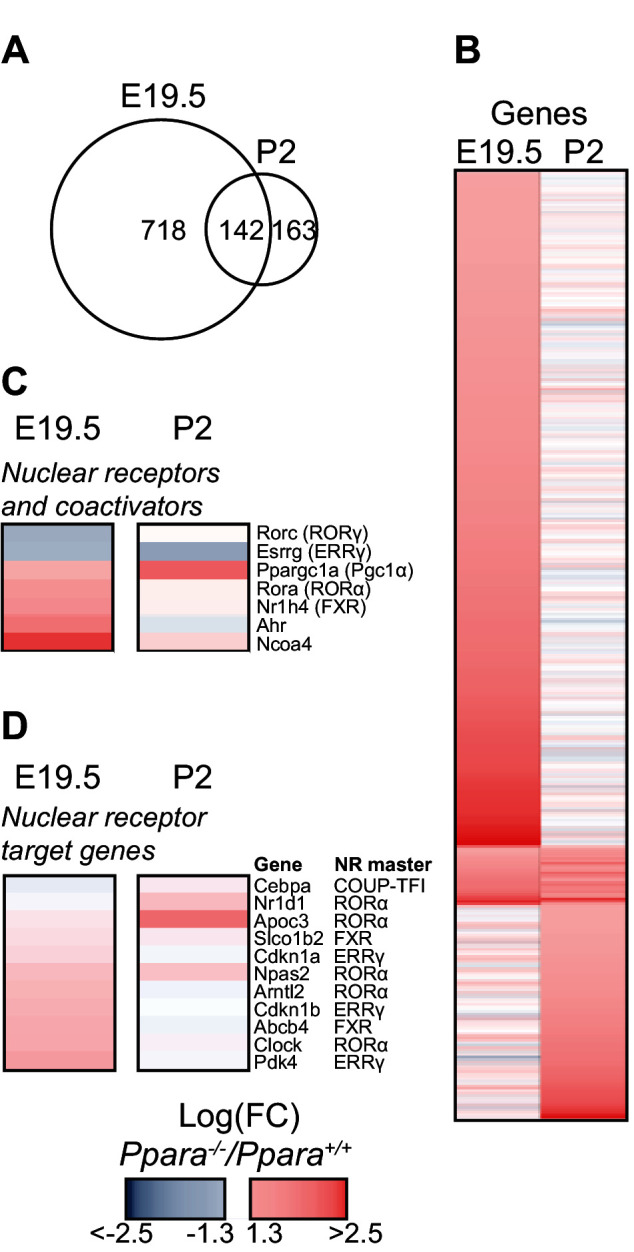
PPARα deficiency leads to compensatory up-regulation of genes.(A) Venn diagram depicting the number of up-regulated genes in the Ppara-/-liver with overlapping PPARα regulation (false discovery rate <0.05) before (E19.5) and after (P2) birth. The absolute fold change cut-off value was set at 1.3. (B) Heat map of genes significantly altered at E19.5 (left panel) or P2 (right panel) in Ppara-/- livers (red: up-regulation; blue: down-regulation). Genes were grouped by fetal or postnatal expression and ordered by strength of PPARα regulation based on the logarithmic fold change (logFC). (C,D) Up-regulated and down-regulated nuclear receptors and co-regulators (C) and nuclear receptor target genes (D) in Ppara-/-livers.